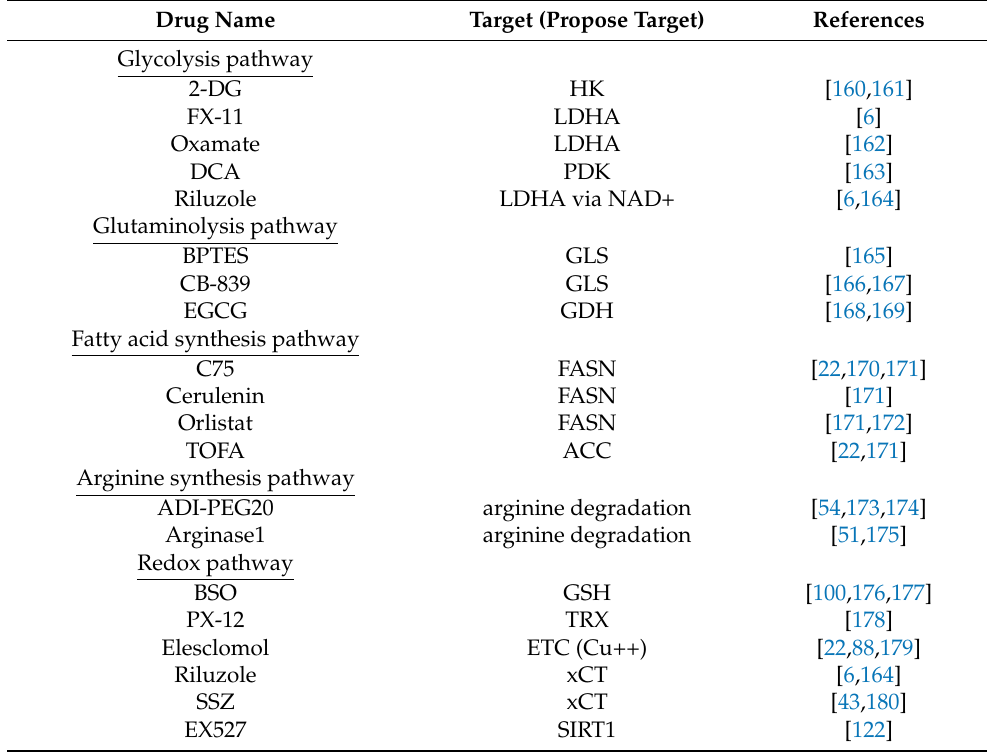
Table 1. Example of potential metabolic targets for cancer